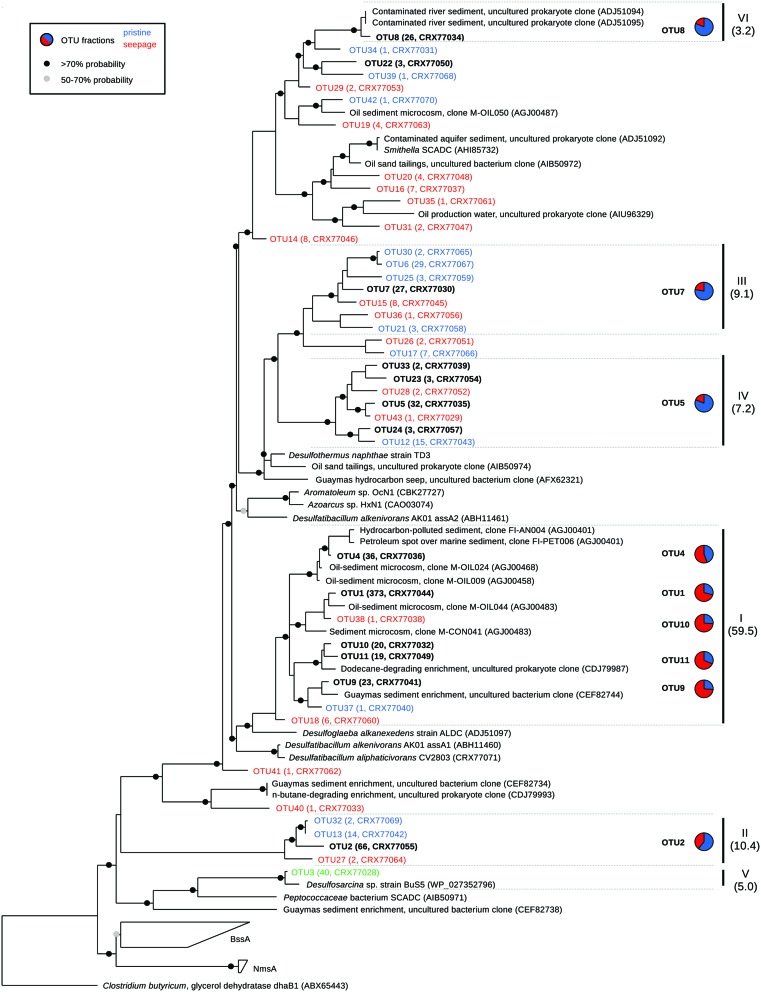
Phylogeny of partial MasD/AssA-like amino acid sequences retrieved from seepage and non-seepage sediments. Operational taxonomic units (OTUs) were defined at a sequence cut-off of 90% amino acid sequence identity. In red: OTUs recovered only from seepage sites; in blue: OTUs recovered only from pristine sites. OTU3 (green) was exclusively recovered from MV enrichments. In black and bold: OTUs that were present in both seepage and pristine sediments. In parentheses: number of sequences per OTU and protein accession numbers. Pie charts show the relative abundance of sequences per OTU (>3 sequences/OTU) retrieved from seepage (red) and pristine (blue) sediments. Clusters I-VI were defined as sharing 75% amino acid sequence identity (in brackets: relative abundance). Circles on nodes indicate bootstrap values according to the legend.